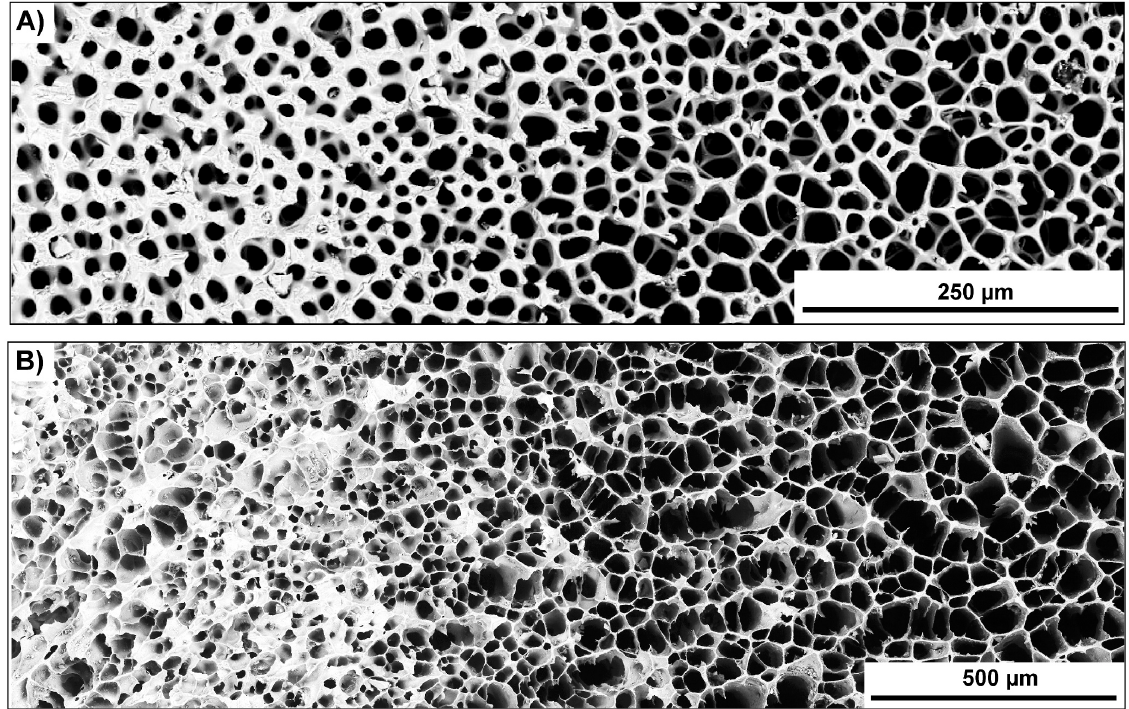
Figure 19. Comparable display of BSE images of the spine microstructure of Phyllacanthus imperialis and of the structural graded ceramic manufactured via freeze-casting. The cross section (perpendicular to the z-axis) of the spine microstructure is displayed in ( A ) demonstrating the radiating layer and medulla. Part of the structural graded freeze-cast ceramic with its cross section is presented in ( B ).